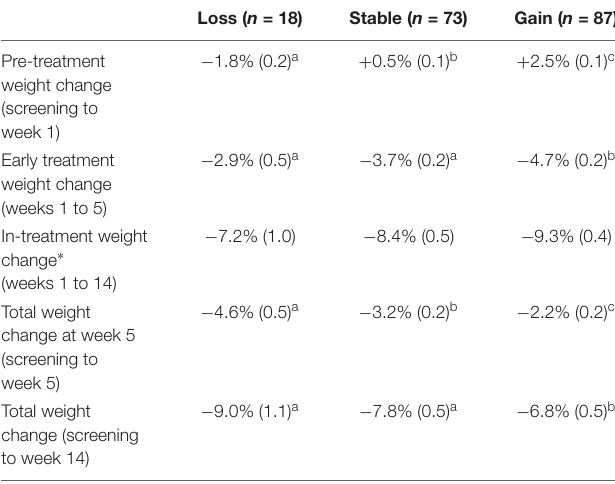
TABLE 2 | Differences among pre-treatment weight change groups in weight change percentage, controlling for screening visit BMI and number of days between screening and week 1 of treatment.